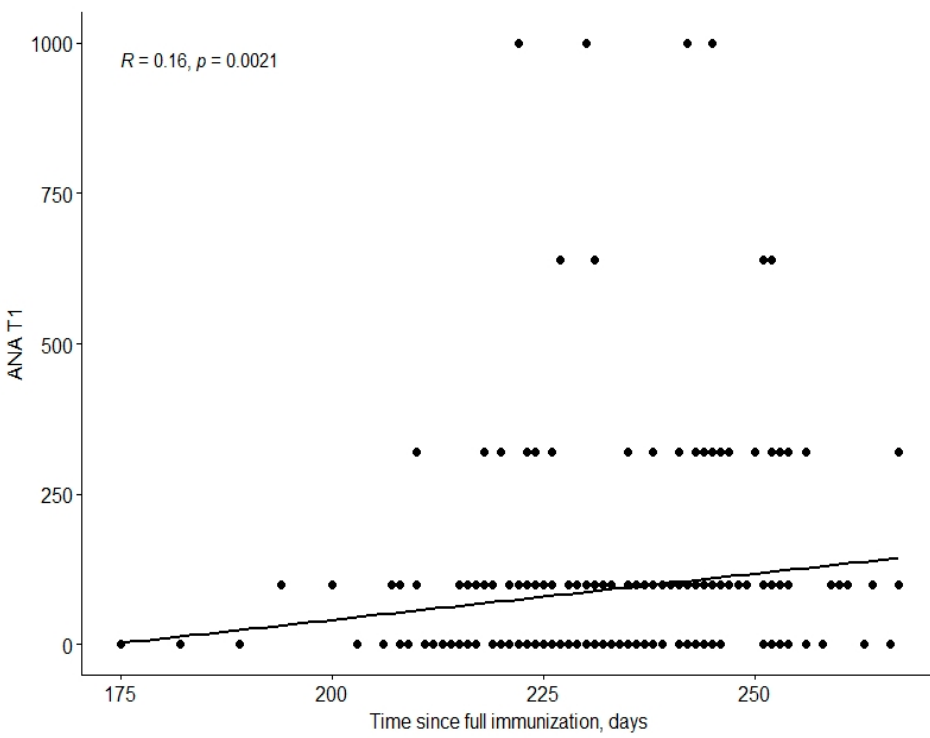
Figure 2. The relationship between time since complete immunisation and ANA values. The strength of these correlations is weak (R = 0.16). Abbreviations: ANA—antinuclear antibodies; T1—laboratory assay before the third dose (median number of days: 230).